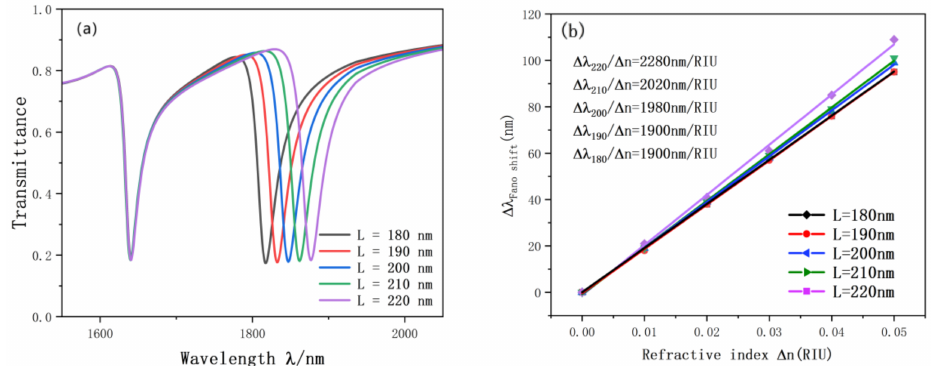
Figure 8. ( a ) Transmission spectrum of g variation; ( b ) the sensitivity of L changes to fit the line.